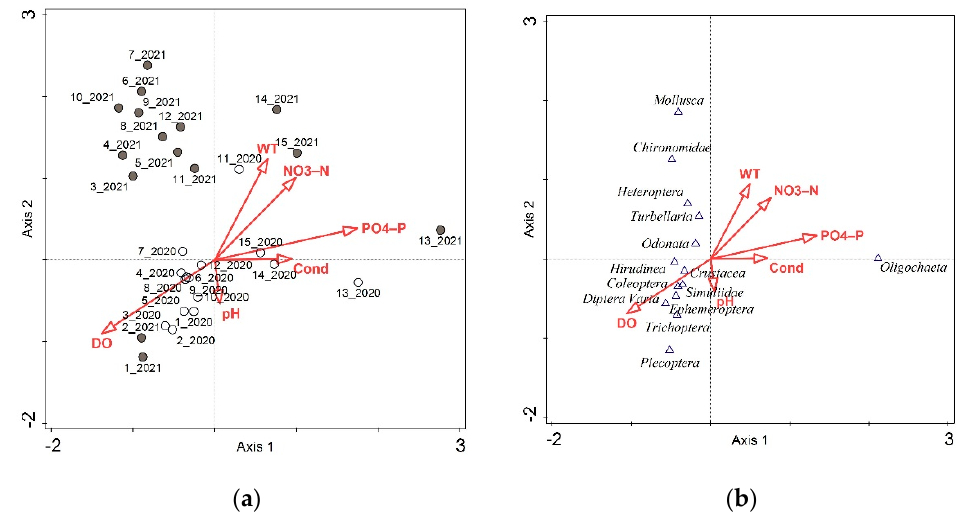
Figure 8. CCA of the physicochemical factors of the studied sites ( a ) and taxa ( b ). (The red arrows show the distribution of environmental factors in the ordination space) Table 2. Eigenvalues, variations and correlation of the CCA.